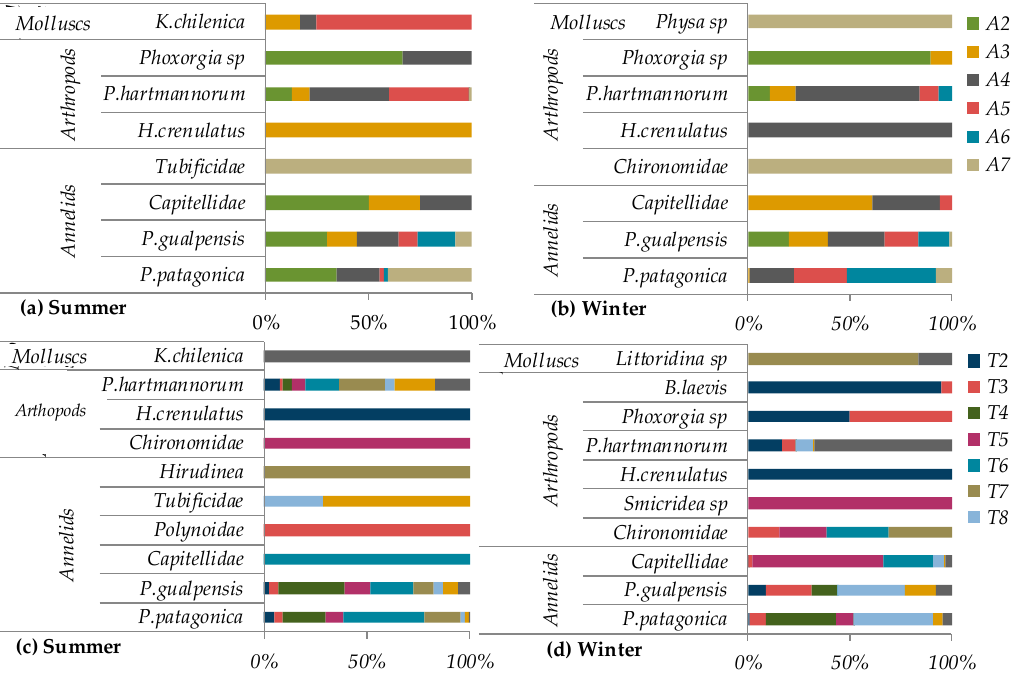
Figure 7. Relative abundance of the macroinvertebrate community structure ( a , b ) Rocuant-Andalién wetland, ( c , d ) Tubul-Raqui wetland.